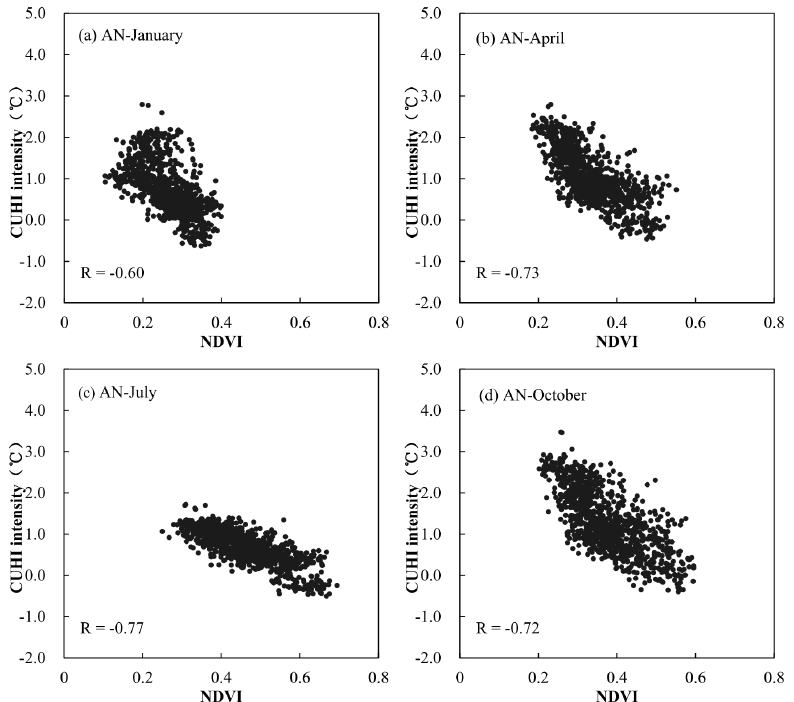
Figure 13. Scatter plots of nighttime-CUHI intensity vs. NDVI for four representative months during the period 2002–2013 at Aqua nighttime overpass. ( a ) January; ( b ) April; ( c ) July; and ( d ) October.